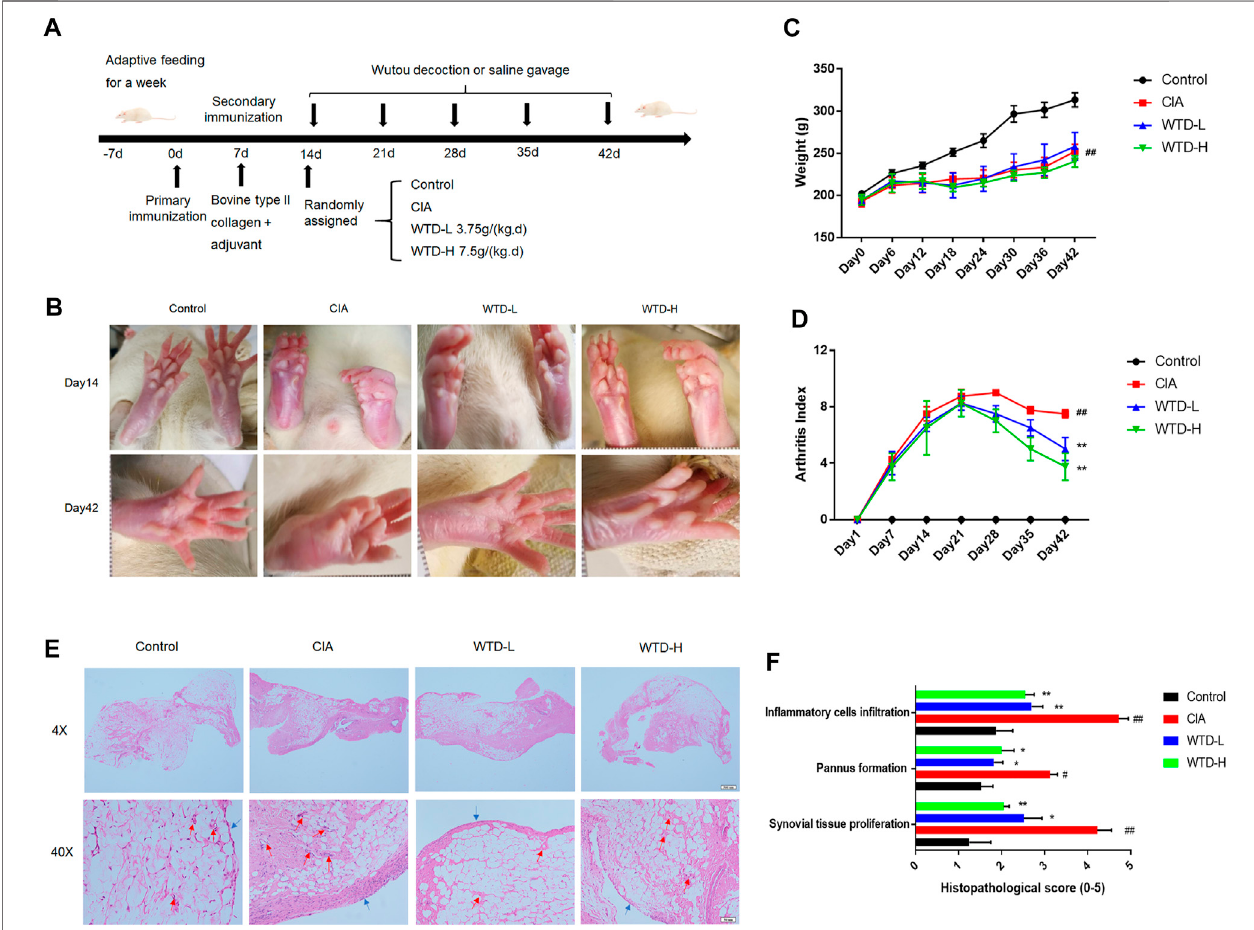
FIGURE2| WTDtreatmentamelioratedCIArats. (A) SchematicofCIAratmodelinductionandWTDintervention. (B) Representativeimagesofthehindpawsfrom thedifferentgroups. (C) Theweightsand (D) arthritisindexesofCIAratstreatedwithPBS,WTD-L(3.75 g/kg)orWTD-H(7.5 g/kg)weremonitoredevery6 days. (E) The synovium of the knee joint was sectioned for hematoxylin-eosin staining. Representative joint tissue sections are shown (original magni fi cation, × 40 and × 200). (F) The histology scores of synovial tissue proliferation, pannus formation, and in fl ammatory cell in fi ltration. The results were expressed as mean ± SE. N (cid:2) 6. # p < 0.05, ## p < 0.01versusthecontrolgroup;* p < 0.05,** p < 0.01versustheCIAgroup.CIA,TheCollagen-inducedarthritisgroup;WTD-L,thelowdoseWutoudecoctiongroup (3.75 g/kg/day); WTD-H, the high dose Wutou decoction group (7.5